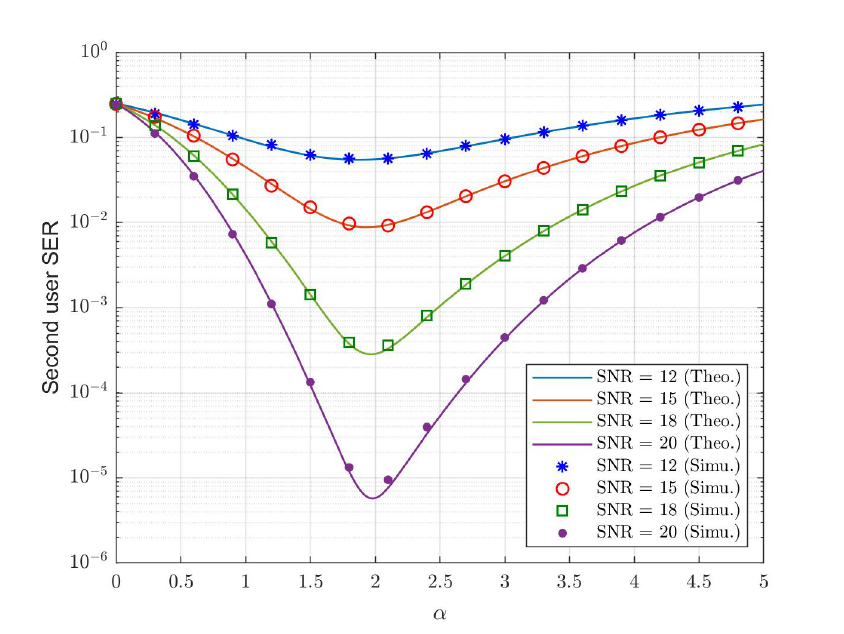
Figure 13. SER 2 with α at different SNR